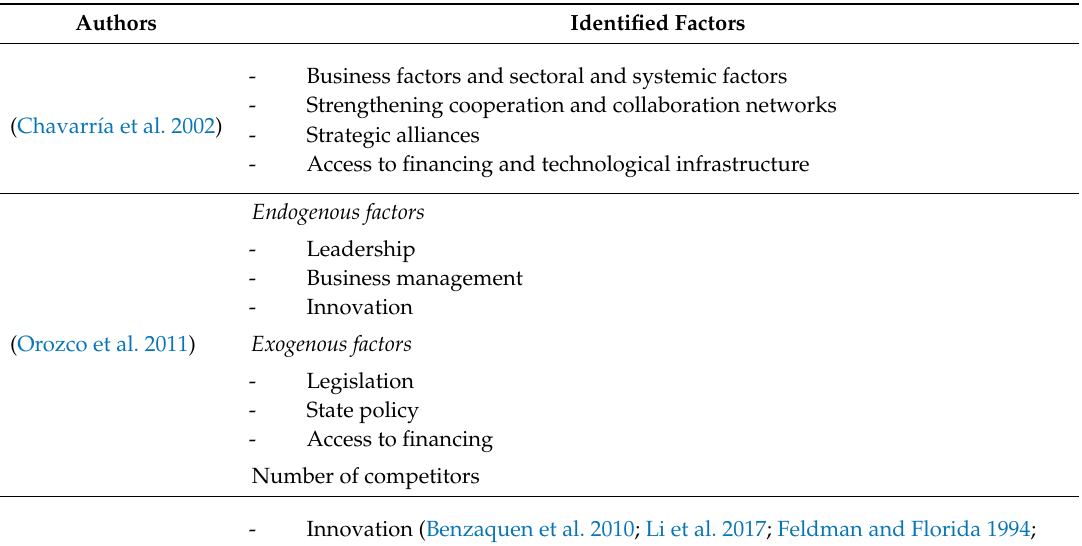
Table 2. Cluster competitiveness